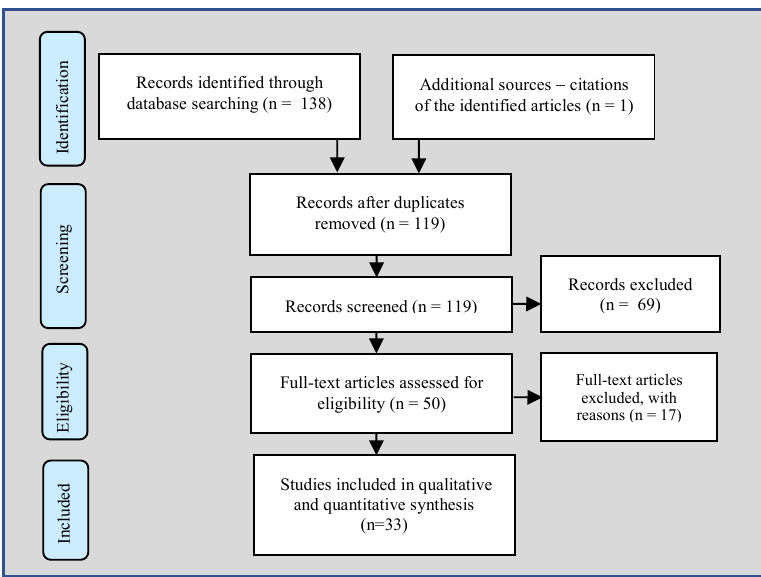
Fig. 1. Literature search and retrieval protocol based on PRISMA Flow